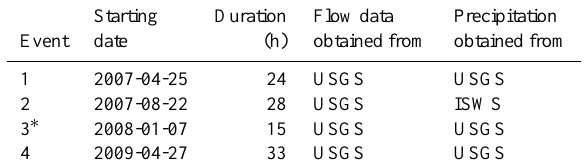
Table 3. Four sets of observed hydrograph and precipitation.